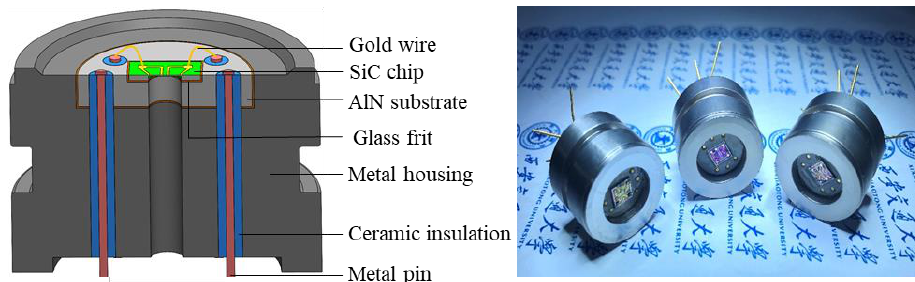
Figure 9. Gold wire bonding package of the SiC pressure sensor.